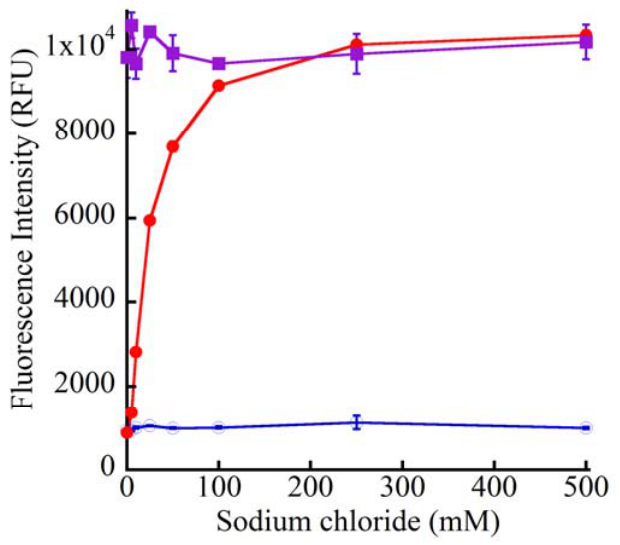
Figure 9. Halide inhibition of laccase-catalyzed CA oxidation. Indicated concentrations of NaCl were added either during the enzymatic reactions (closed circles, red tracing) or after stopping the reactions with 250 mM KOH (open circles, blue tracing). The effect of NaCl on the fluorescence of unmodified CA is shown by the purple tracing connecting the closed squares. Nearly identical profiles were generated by exciting the samples at 290, 310 and 340 nm and measuring the emission at 416 nm. The data shown in this figure were obtained by excitation of CA at 290